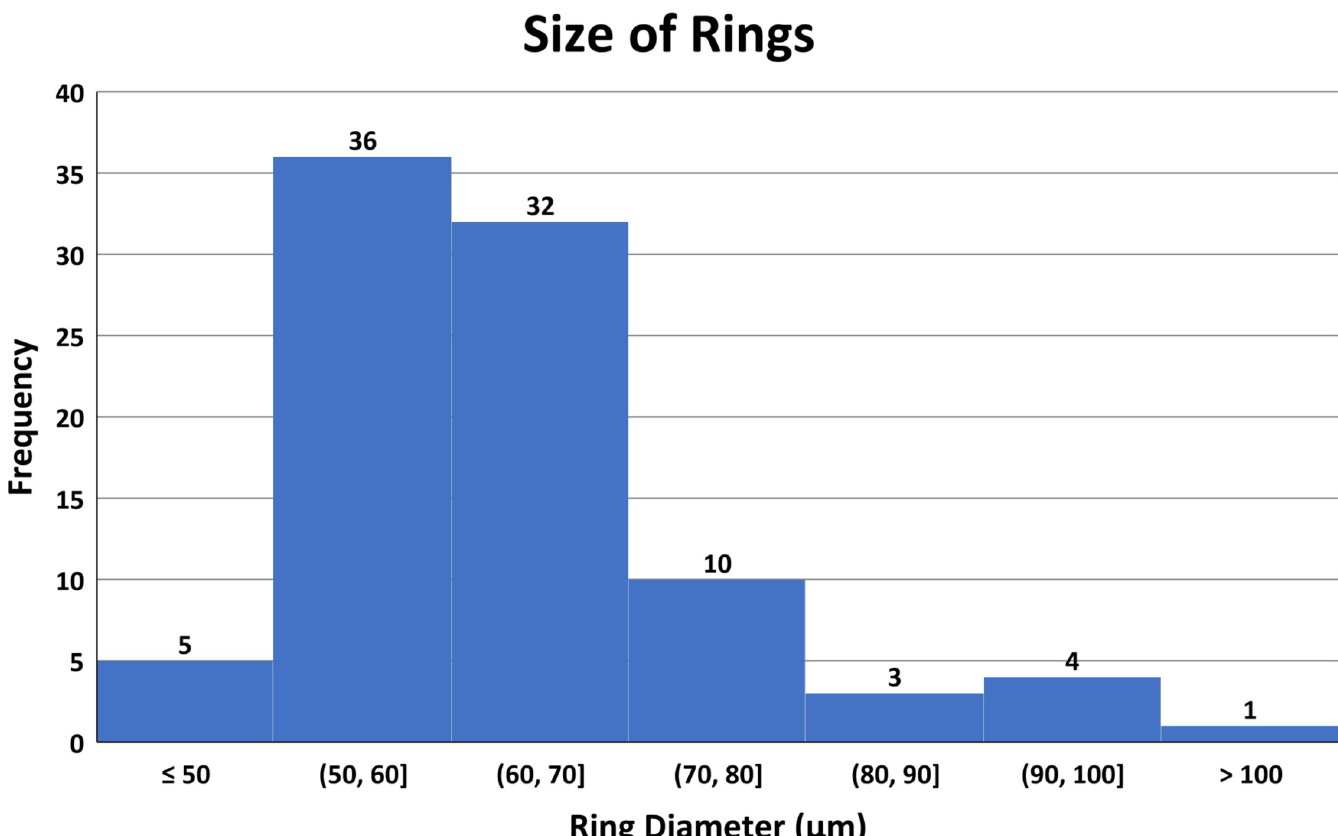
Fig 5. Histogram consisting of 90 perpendicular diameter measurements from 45 nanoparticle